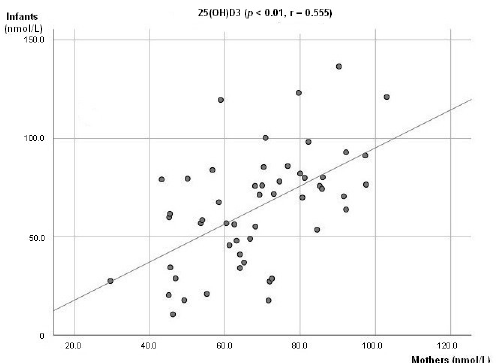
Figure 2. Association between mother’s and infant concentration level of 25(OH)D3.